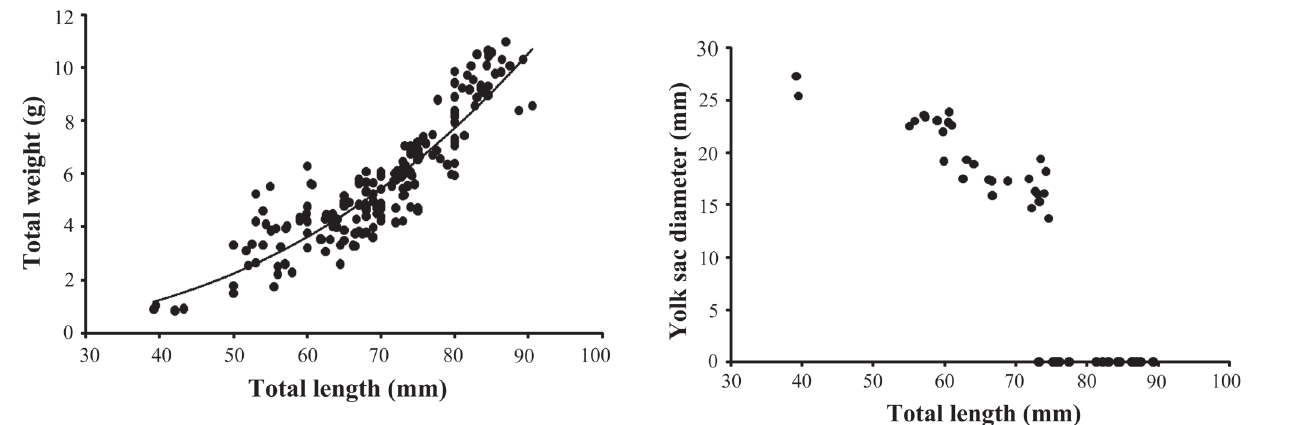
) and weight e (dotted line)= 7 x Fig. 11. Relationship between total length of embryos and e external yolk sac diameter (n= 49).